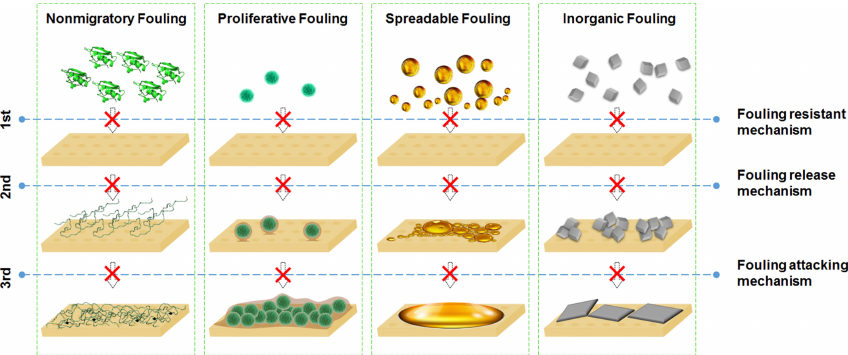
Figure 6. The passive and active antifouling strategies for non-migratory, spreadable, proliferative and inorganic foulants. Reprinted from [133], Copyright (2018) with permission from